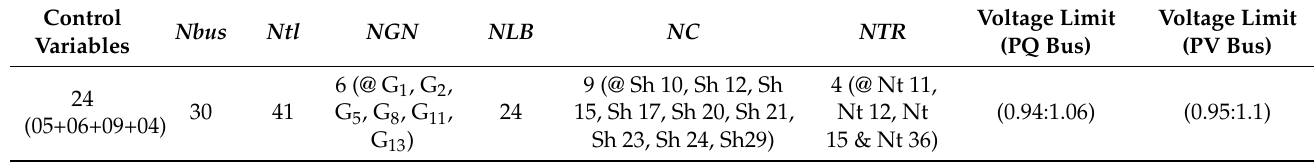
Table 1. Details of the IEEE 30-bus test